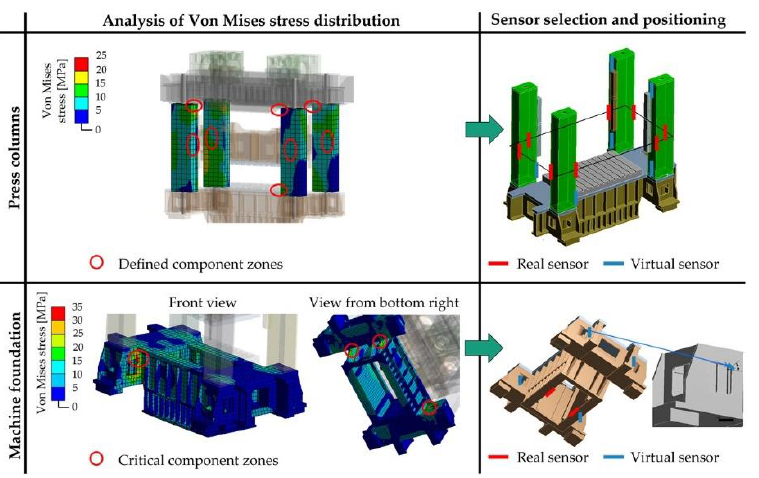
Figure 6. Simulative analysis for example assemblies regarding sensor selection and positioning.